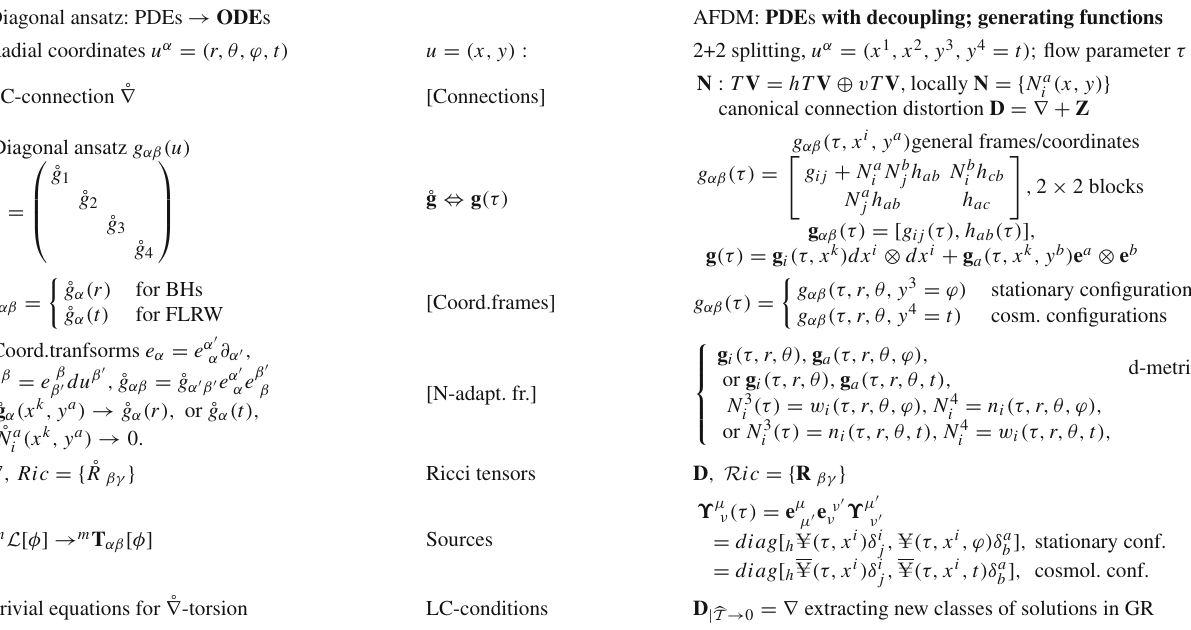
Table 1 Entropic quasiperiodic flow modified Einstein eqs as systems of nonlinear PDEs and the Anholonomic Frame Deformation Method, AFDM , for constructing generic off-diagonal exact, parametric, and physically important solutions Diagonal ansatz: PDEs → ODE s AFDM: PDE s with decoupling; generating functions Radial coordinates u α = ( r ,θ,ϕ, t ) u = ( x , y )